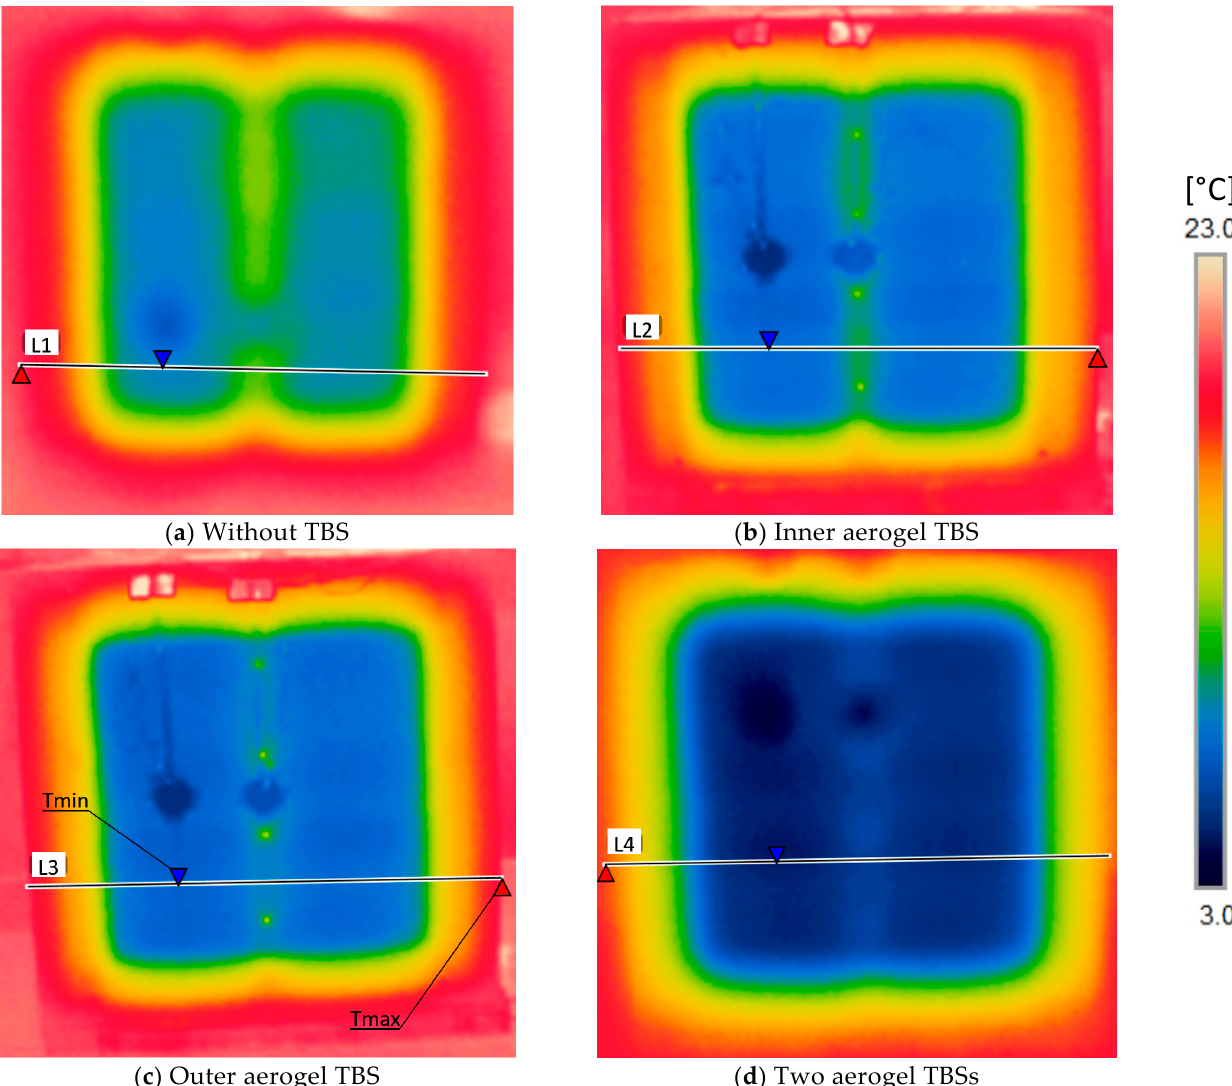
Figure 7. Infrared thermography photos of the LSF partition walls: cold side.